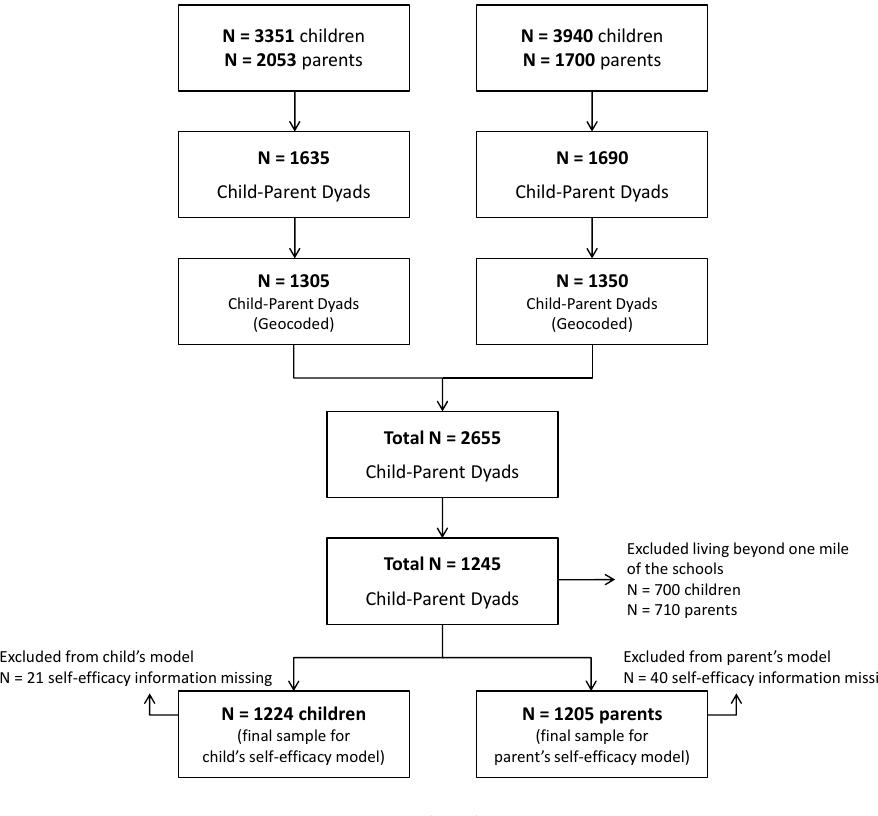
Figure 1. Sample Selection Process.